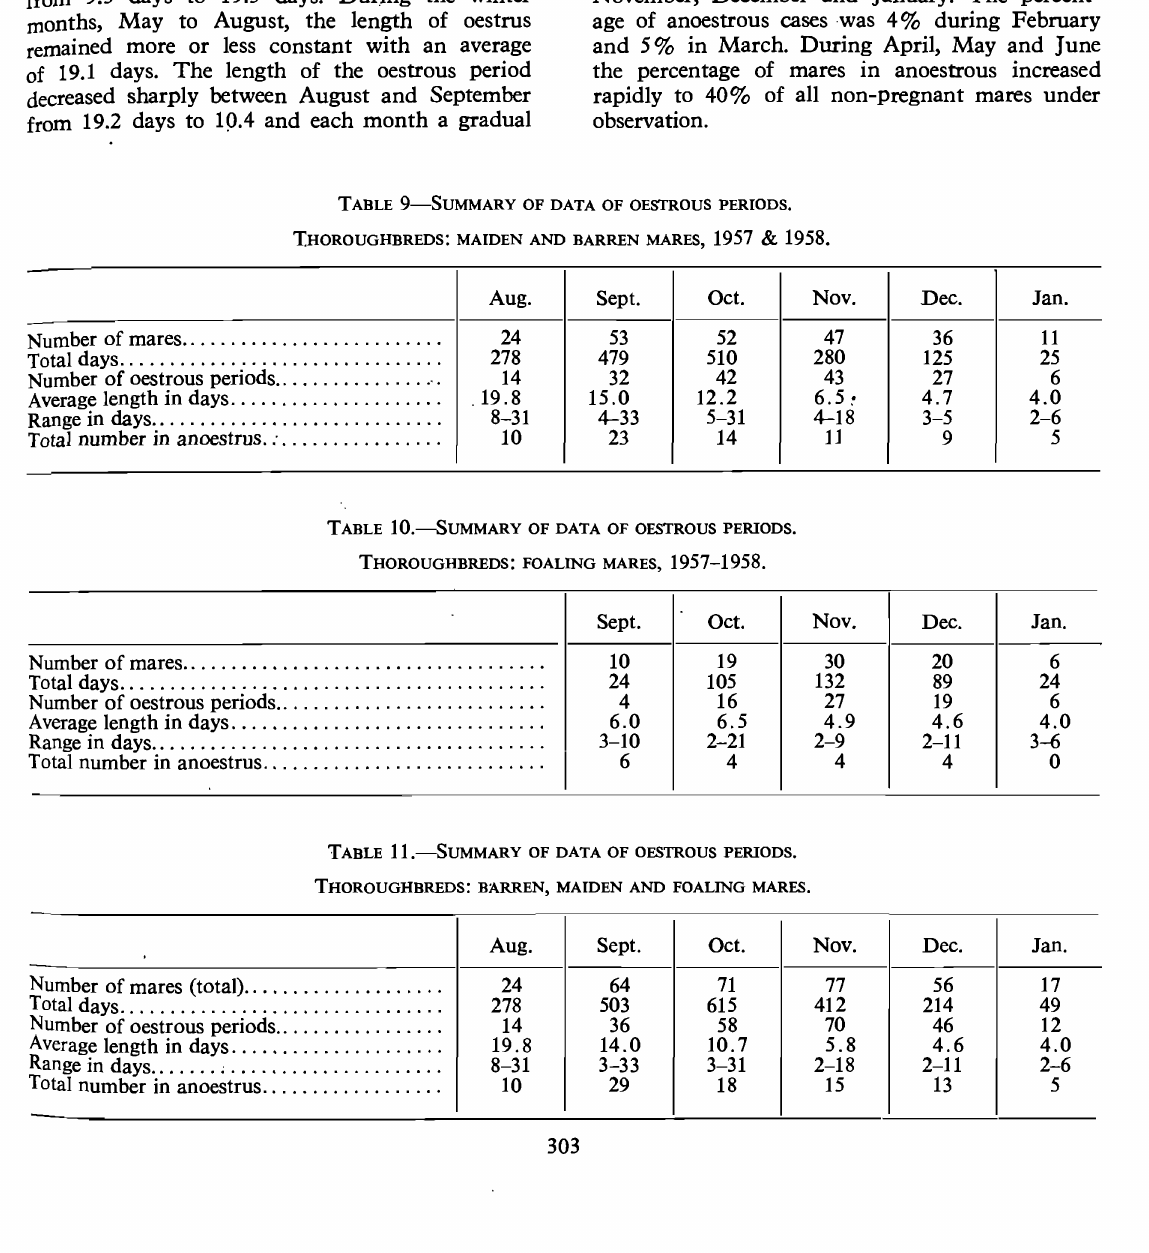
TABLE 11.-SUMMARY OF DATA OF OESTROUS PERIODS. THOROUGHBREDS: BARREN, MAIDEN AND FOALING MARES.